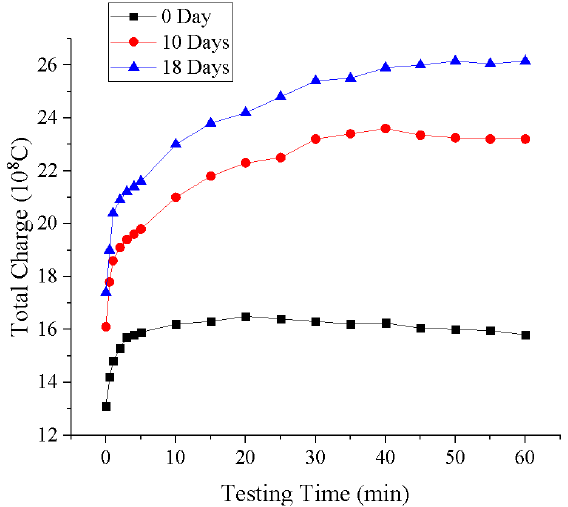
Figure 8. Total amount of charges in the oil ‐ paper insulation with paper aged for different days under the electrical field of 30 kV/mm [19].